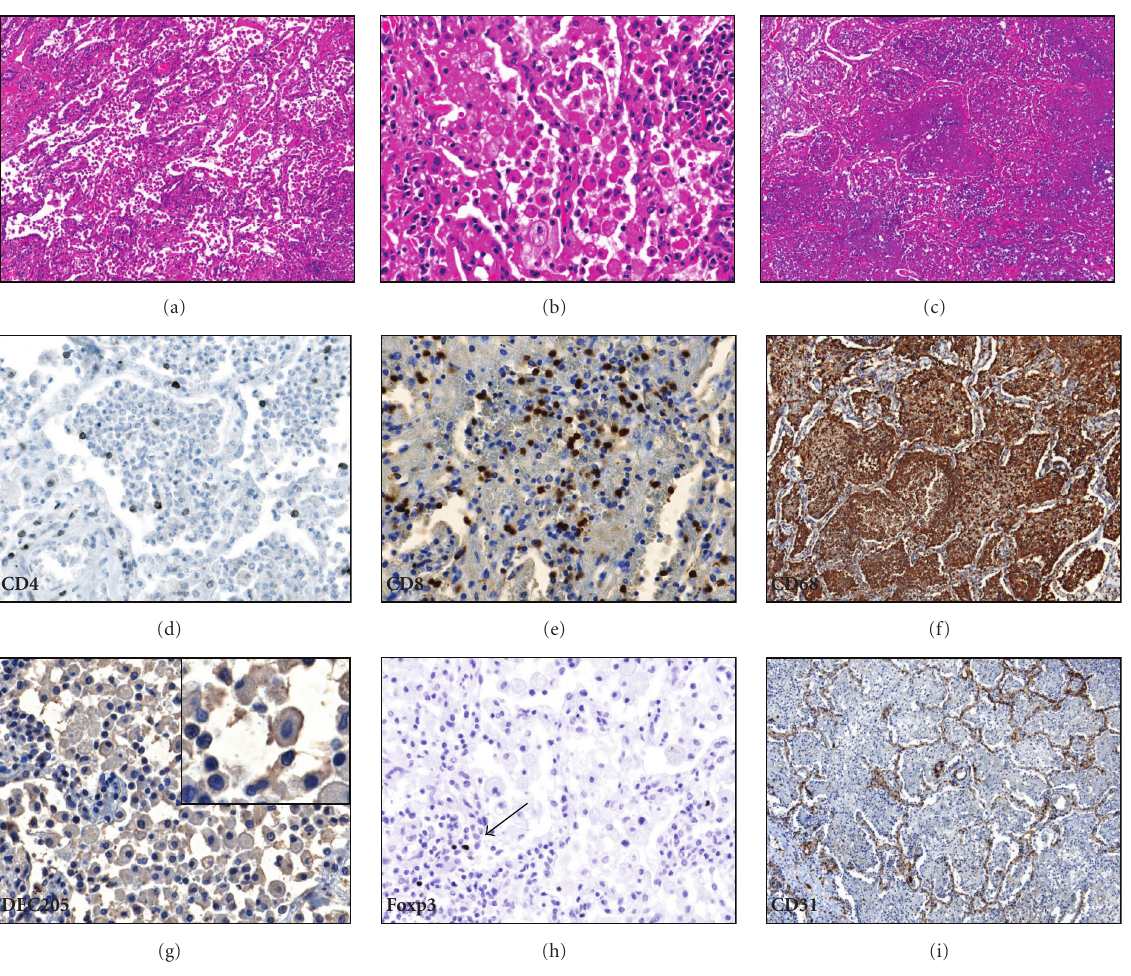
Figure 2: Lipid pneumonia. (a) Alveoli are filled with macrophages and the alveolar walls have high numbers of lymphocytes, 100x. (b) Macrophages in the lipid pneumonia have a foamy appearance, 400x. (c) The cells in the alveoli may undergo necrosis to produce a homogenous appearance, 100x. (d) Relatively few CD4+ cells are present in lipid pneumonia, 400x. (e) Abundant CD8+ cells are noted in the alveoli as well as in the alveolar walls, 400x. (f) Foamy cells stain strongly with the CD68 marker. (g) Foamy macrophages in the lipid pneumonia are frequently positive for the dendritic cell marker DEC-205, 400x. The insert shows a detailed image of a DEC-205-positive macrophage. (h) T-regulatory cells were observed in regions of lipid pneumonia (arrow), 400x. (i) The CD31 stain highlights the disrupted lung architecture,